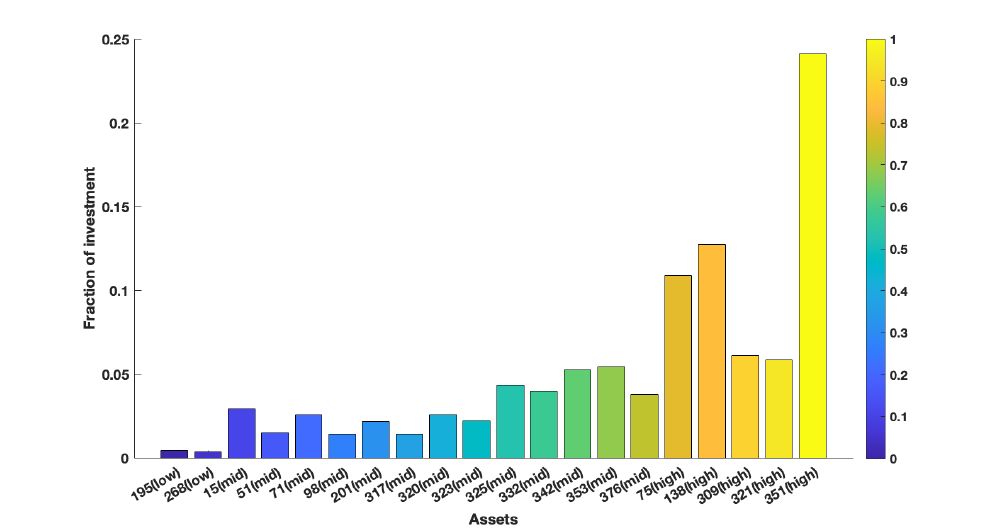
Figure 8. The assets’ weights of each estimation under the out-of-sample data for N = 400.